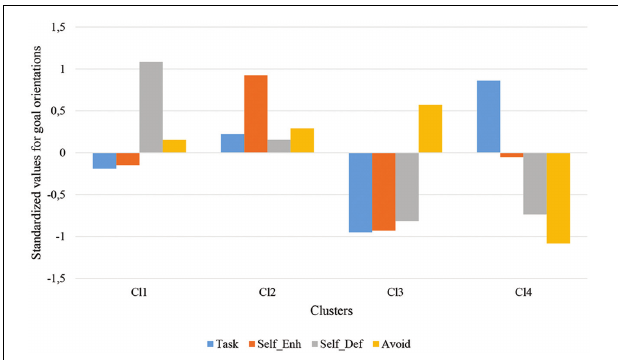
FIGURE 3 | Students’ standardized mean scores on achievement goals across the four clusters. Task, Task orientation; Self_Enh, Self-enhancing ego orientation; Sef_Def, Self-defeating ego orientation; Avoid, Avoidance orientation.